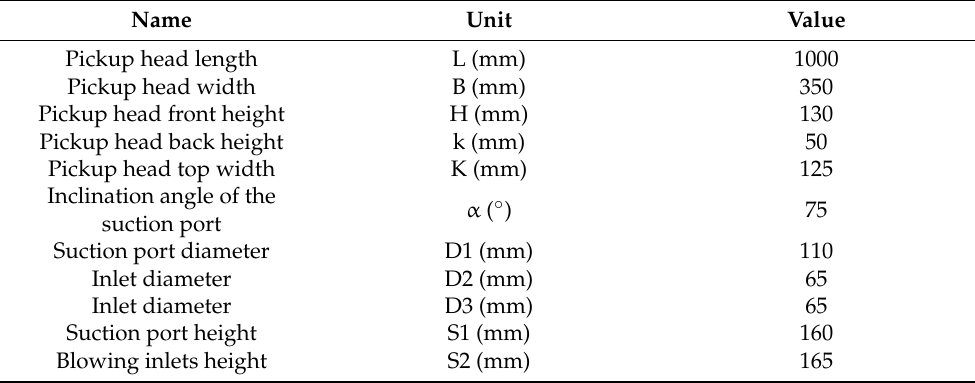
Figure 2. Schematic representation of the physical model of the pickup head. ( a ) Isometric view, ( b ) Side view. Table 1. Technical parameter of the pickup head regenerative air vacuum road